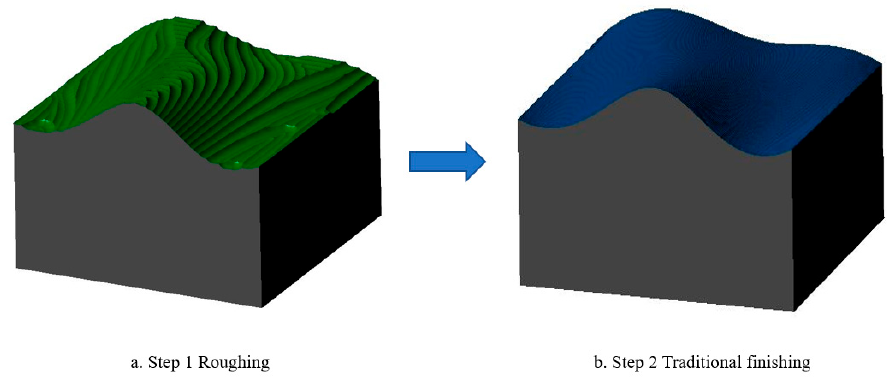
Figure 11. Sample 1 simulation processing process, ( a ) Roughing, ( b ) Traditional finishing.